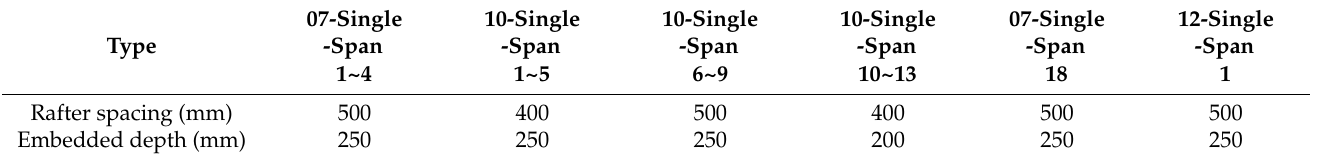
Table 2. Foundation types of single-span greenhouse [3].